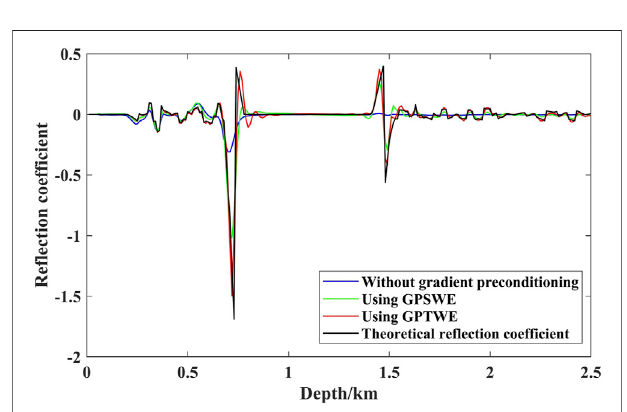
FIGURE 11 | Single-trace display of imaging results after 60